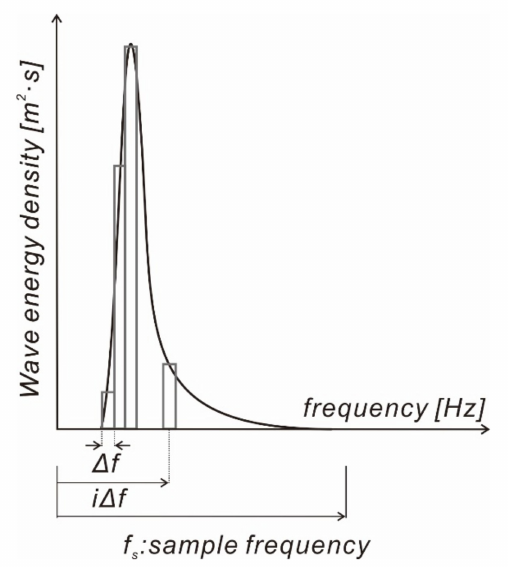
Figure 7. Partition of target wave